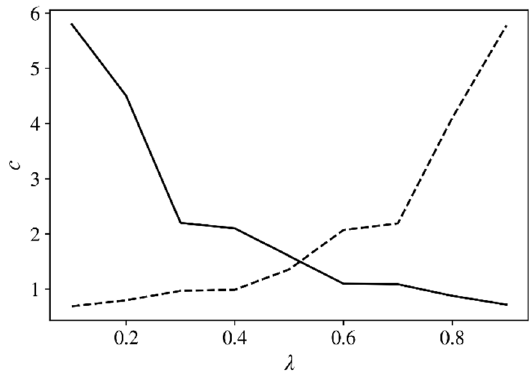
Figure 2. The dependence of internal prices 𝑐̄ (cid:2869) (solid line) and 𝑐̄ (cid:2870) (dashed line) on the fraction 𝜆 of total food supply in the first region. total food supply in the first